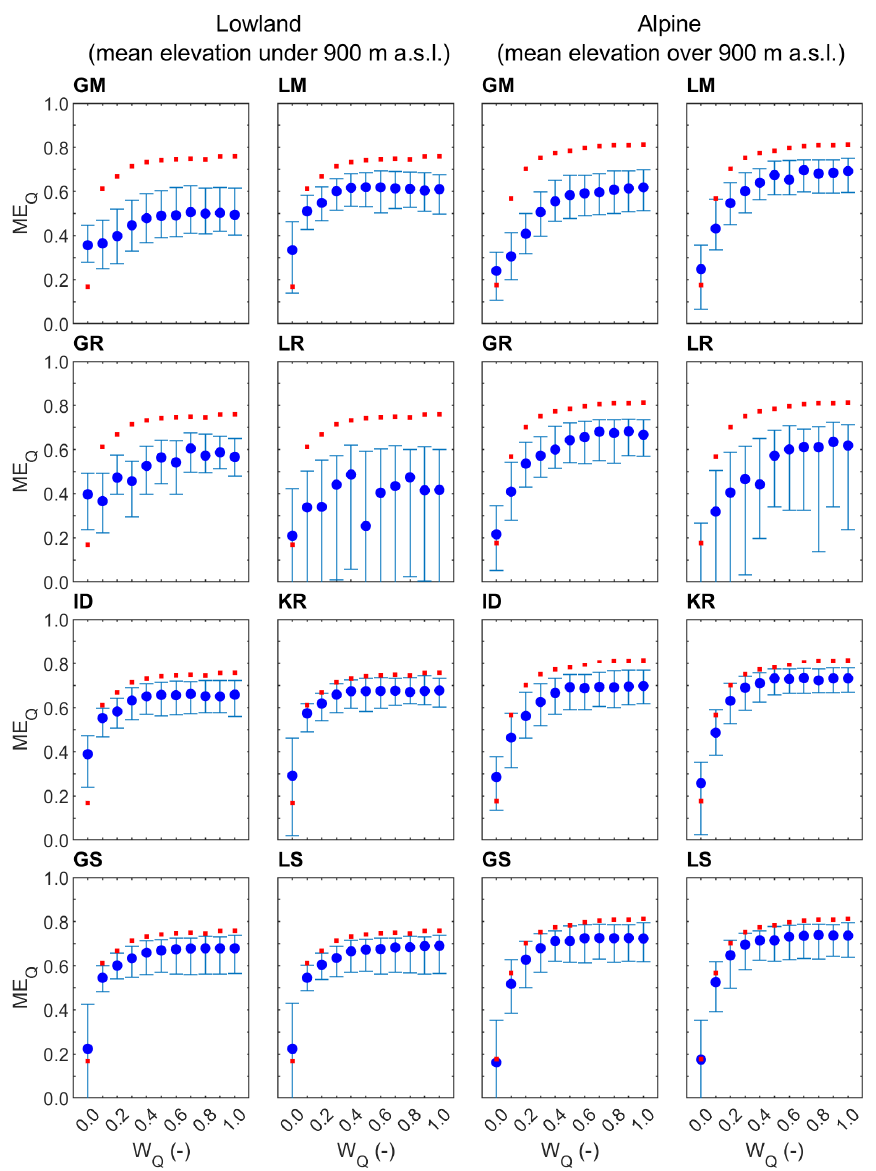
Figure 2. Median and regional scatter of the leave-one-out runoff model efficiency (Eq. 5) obtained by eight groups of parameter transfer methods and 11 calibration weights for lowland (94) and alpine (119) catchments in the calibration (2000–2010; blue symbols) period. Blue circles represent the median and whiskers the 25% and 75% quantiles of the leave-one-out efficiency. Red symbols show the median of the at-site runoff model